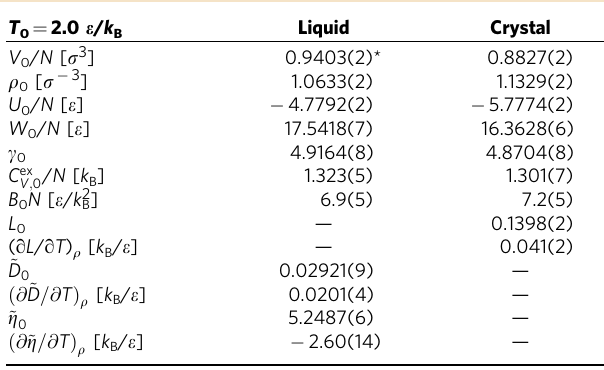
Table 1 | Quantities characterizing the two reference state points in